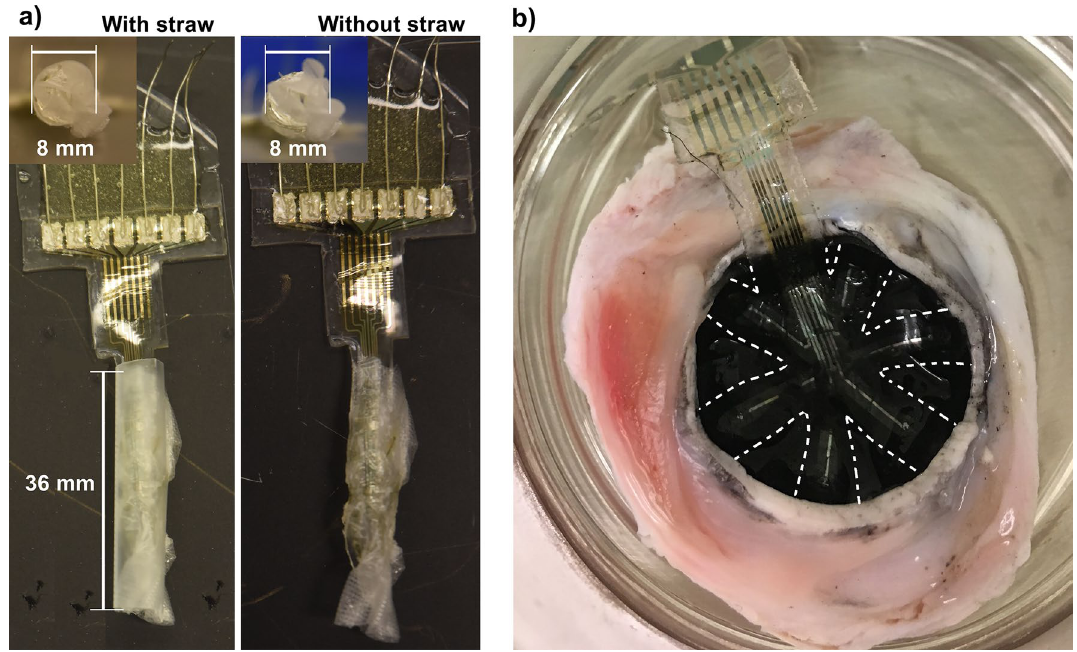
Figure 6. Simulation surgery to implant the multilayered device. ( a ) Preparation of the device before implantation. The multilayered prosthesis was rolled up with PVA film and placed into a straw with one side cut open. The inset is the cross-section of the rolled-up device, and the diameter is measured as 8 mm. After dehydration and the removal of the straw, the device stayed fixed and compact at a diameter of 8 mm. ( b ) Photo of the fully deployed multilayered electrode in pig eye after removal of the cornea and scleral rim. The dotted white line outlines the edges of the 6 petals.